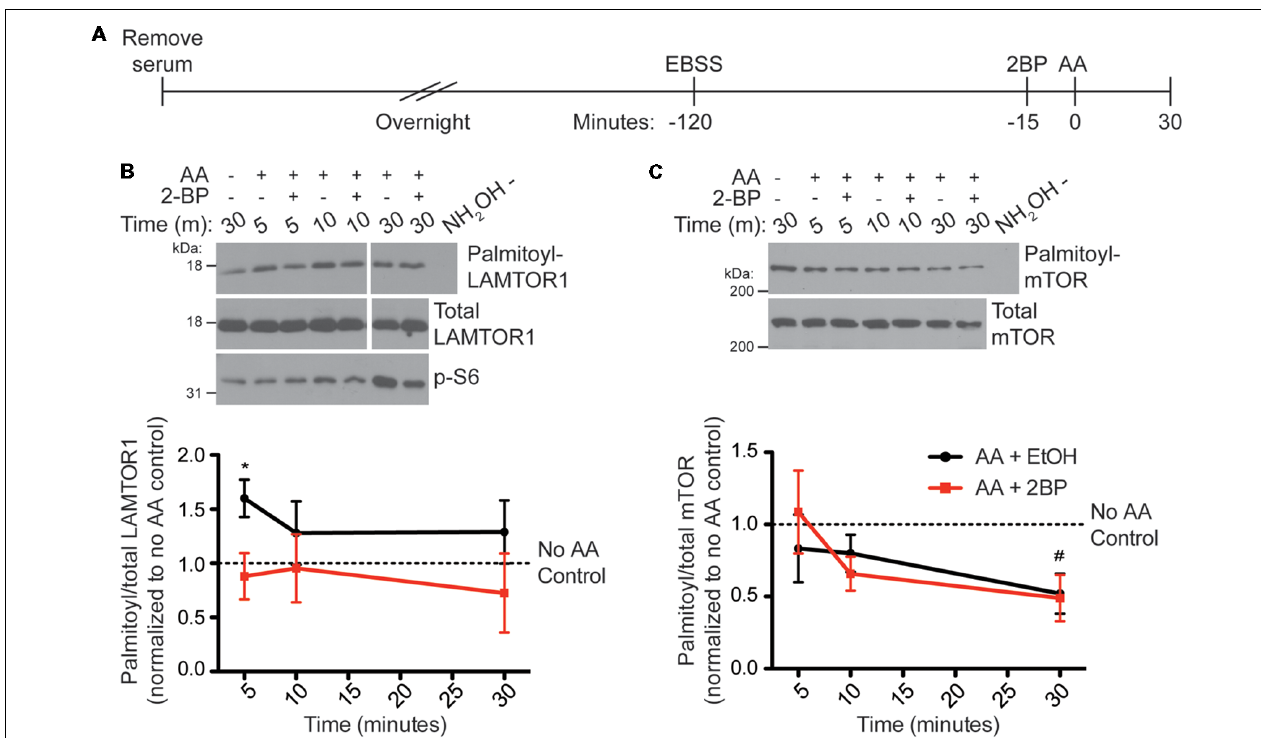
FIGURE 5 | LAMTOR1 palmitoylation is rapidly increased and mTOR palmitoylation is decreased by amino acid stimulation (of mTORC1) in HEK293T cells. (A) Scheme of the AA stimulation paradigm. HEK293T cells were incubated in serum-free media 16–20 h (overnight) prior to being placed in EBSS. One hour and 45 min later cells were treated with ethanol (EtOH) or 20 µ M 2BP to inhibit palmitoylation. Cells were stimulated 15 min later with 2 × MEM amino acids (AA) and harvested at 5, 10, and 30 min post-stimulation. Control cells were lysed 30 min after sham stimulation with buffer alone. Palmitoyl-proteins were isolated by ABE and samples were blotted for LAMTOR1 (B) and mTOR (C) in the ABE fraction (top) and total lysate input fraction (middle). Lysates were also blotted for pS6 (bottom panels). Panels are composites of the same Western blot image. Lower histograms show quantified data from N = 4 experiments [ ∗ Student’s t -test with Welch’s correction vs. unstimulated condition (no AA control, first lane of western blot) for LAMTOR1, p = 0.040; # Student’s t -test with Welch’s correction vs. unstimulated condition (no AA control, first lane of western blot) for mTOR, p =